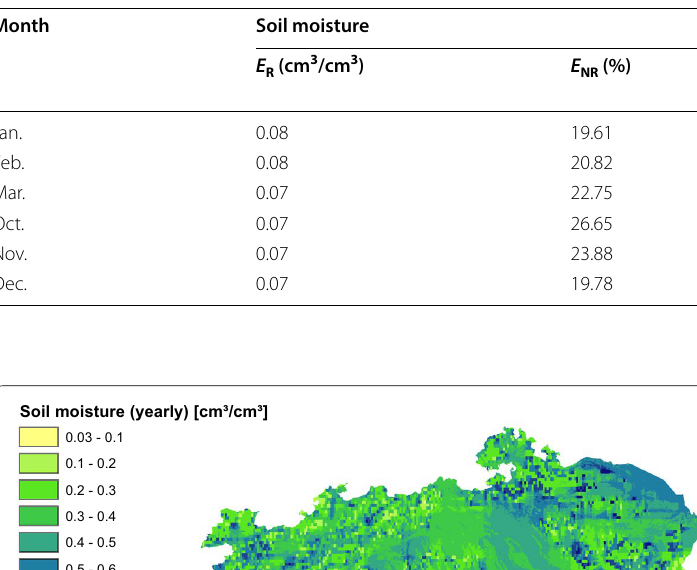
Table 2 Testing RMSE ( E R ) and NRMSE ( E NR , in percentage) for Random Forest models trained for monthly ground soil moisture (Volumetric Water Contents)